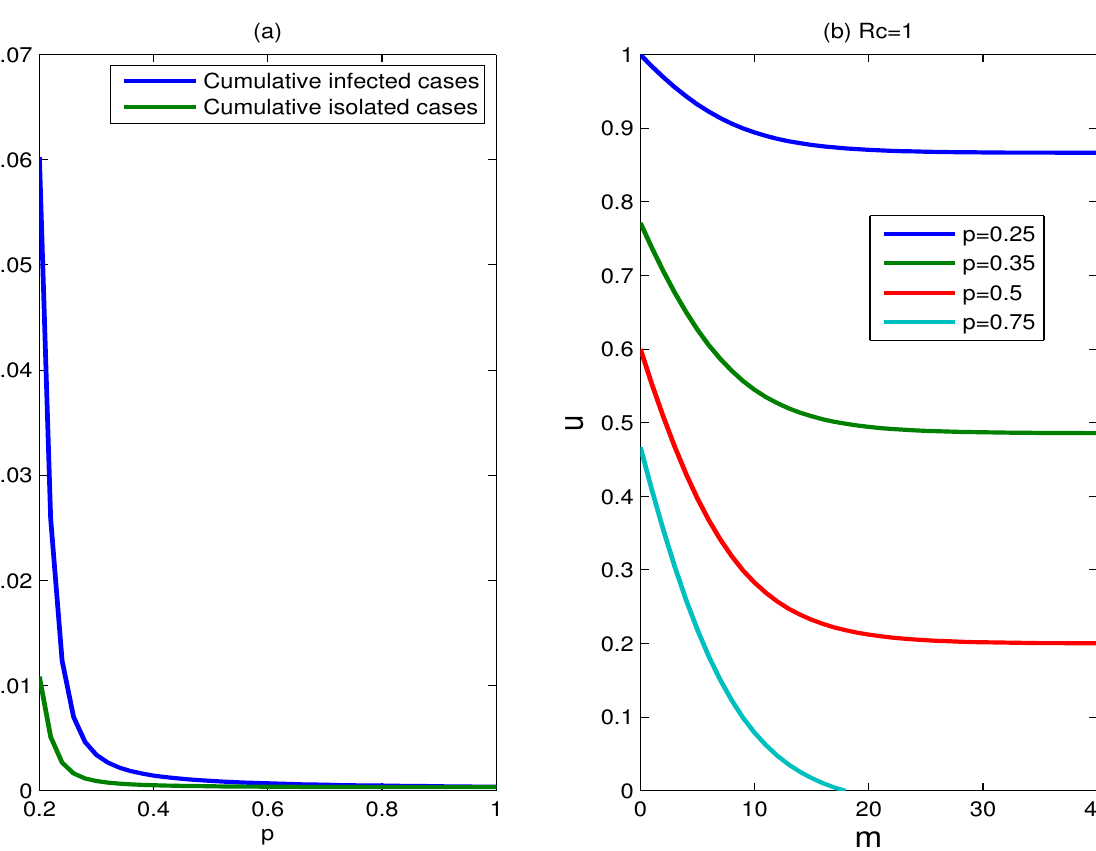
= 1 , for various values of parameter c